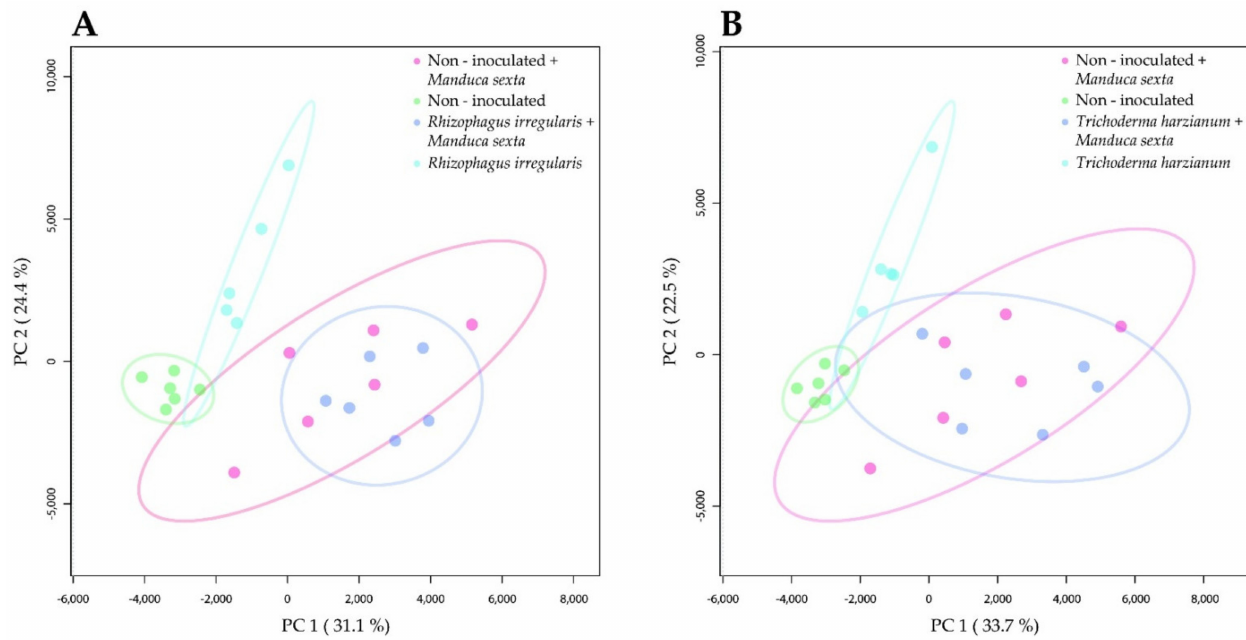
Figure 2. The impact of root colonization by Rhizophagus irregularis or Trichoderma harzianum and Manduca sexta shoot herbivory on the metabolome of tomato leaves. ( A ) Two-dimensional principal component analysis (PCA) scores plot of leaf samples of tomato plants that were non-inoculated or root-inoculated with R. irregularis and not challenged or shoot- challenged with M. sexta for three weeks. ( B ) PCA scores plot of leaf samples of tomato plants that were non-inoculated or root-inoculated with T. harzianum and not challenged or shoot-challenged with M. sexta for three